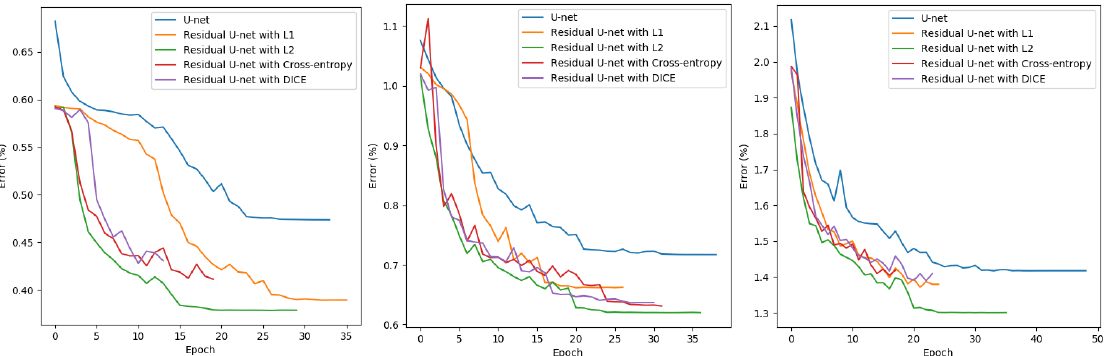
Figure 7. Learning curves of network architectures using different loss functions at target scale 1:10,000 ( left ), 1:15,000 ( middle ) and 1:25,000 ( right ) based on validation